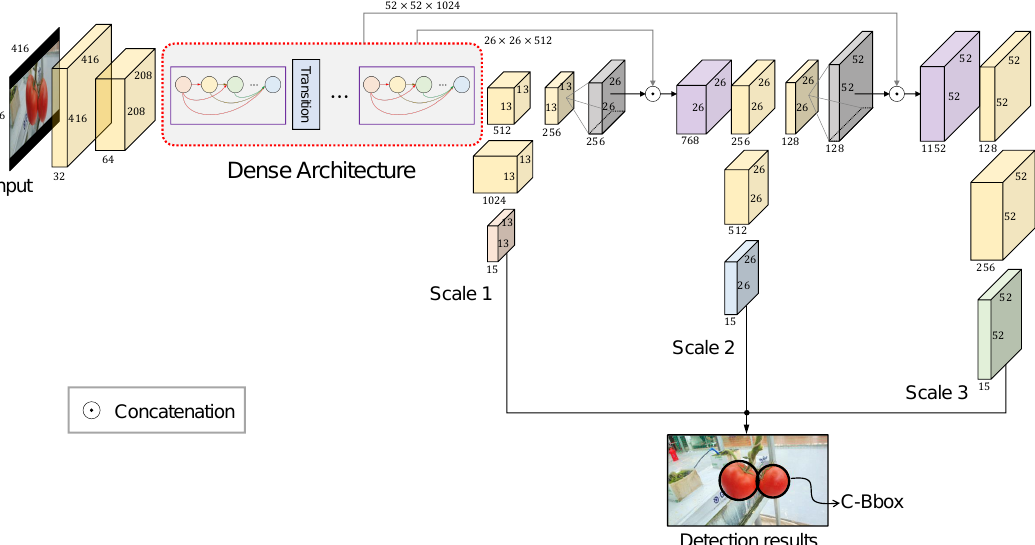
Figure 5. An overview of the proposed model.